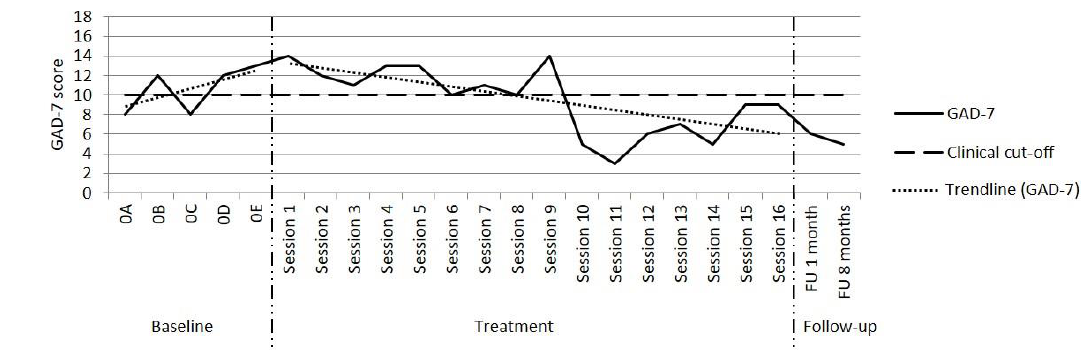
Figure 2: Giovanni’s weekly anxiety (GAD-7) score